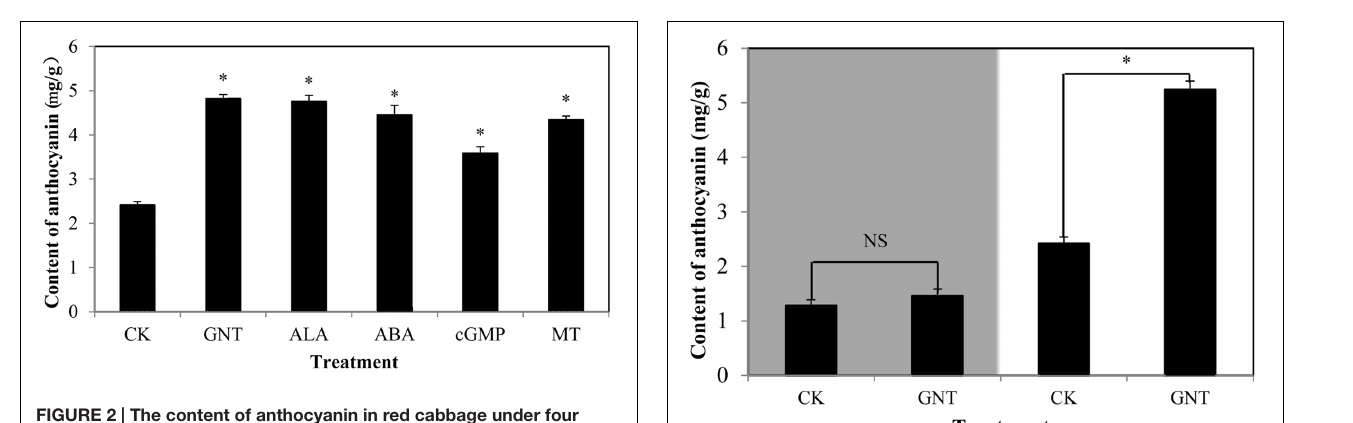
FIGURE 2 | The content of anthocyanin in red cabbage under four treatments: CK (control), GNT (genistein), ALA (5-Aminolevulinic acid), ABA (abscisic acid), cGMP (Guanosine 3 (cid:48) , 5 (cid:48) -cyclic monophosphate) and MT (melatonin). The data are mean ± SD ( n = 3) and the symbol ∗ represents significant difference with CK and treatments at P = 0.05 level.